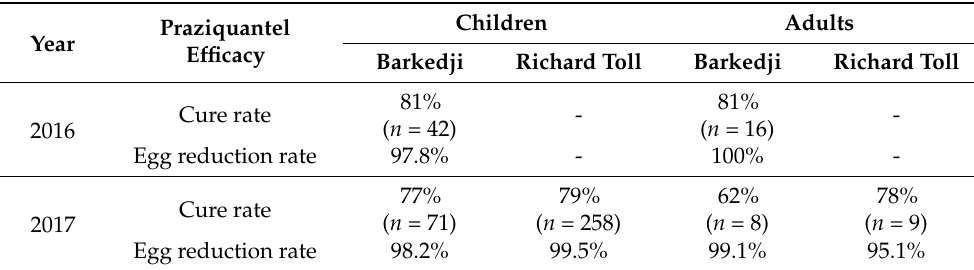
Figure 2. Odds ratios (points) and 95% confidence intervals (horizontal lines) of various morbidity indicators being in category j or above among children in Senegal in 2016 and 2017, depending on the detection of S. haematobium-S. bovis hybrids and adjusted for urogenital and intestinal schistosomiasis infection intensities, age, sex, and study site. For each morbidity indicator, only individuals with genotyped miracidia and complete data on infection intensity, age, sex, and study site were included. Urine strips were used to determine the presence of blood in the urine (hematuria), and the results were expressed as -, +, ++ or +++, indicative of increasing intensity. Table 4. Cure rate and egg reduction rate in children and adults one month after treatment with praziquantel in two study sites in Senegal in 2016 and 2017 (number of individuals examined indicated in parentheses; only individuals with parasitological data both pre- and post-treatment were